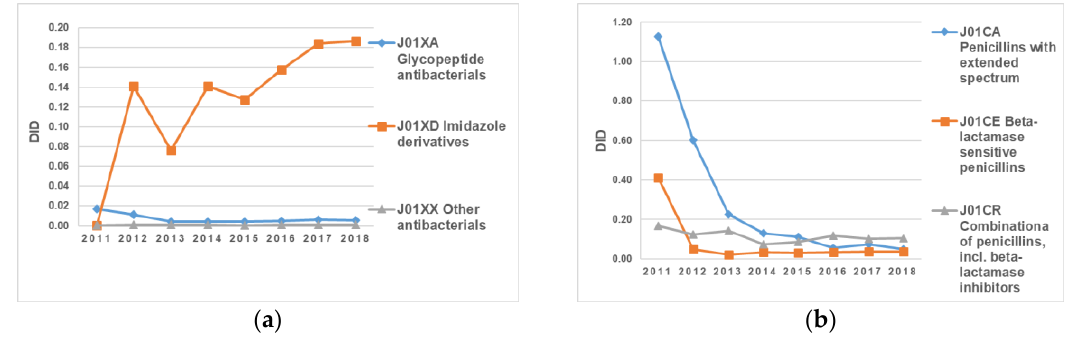
Figure 5. ( a ) Utilization of “J01XA Glycopeptide antibacterials”, “J01XD Imidazole derivates”, and “J01XX Other antibacterials” in Kazakhstan from 2011 to 2018; ( b ) utilization of “J01CA Penicillins with extensions”, J01CE Beta-lactamase-sensitive penicillins”, and “J01CR Combinations of penicillins” in Kazakhstan from 2011 to 2018.